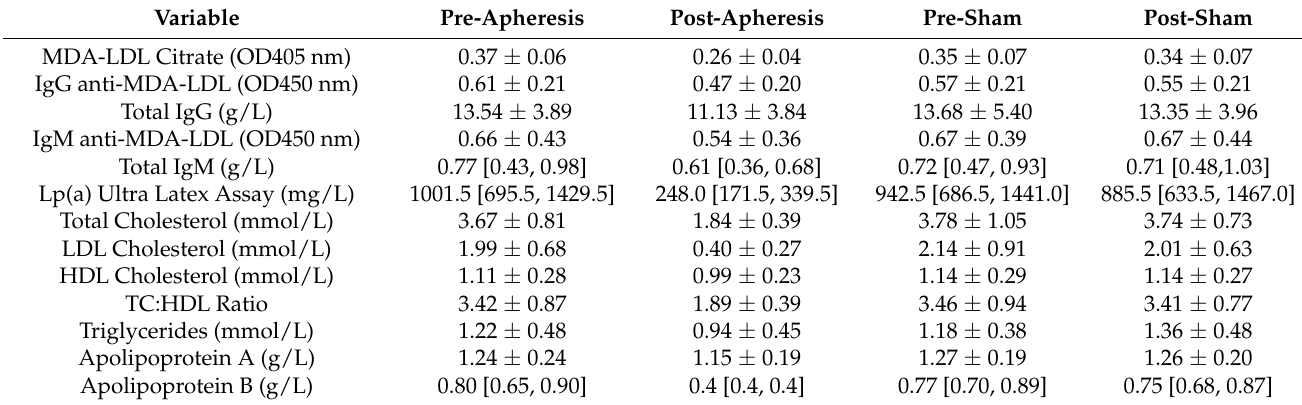
Table 3. Absolute levels of MDA-LDL and their associated antibodies and lipid parameters before and after apheresis and sham shown as mean ± SD or median